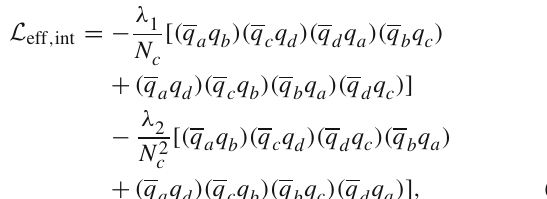
Fig. 6 Leading-order contributions of two-meson states to the direct ( a , b ) and recombination ( c – e ) channels